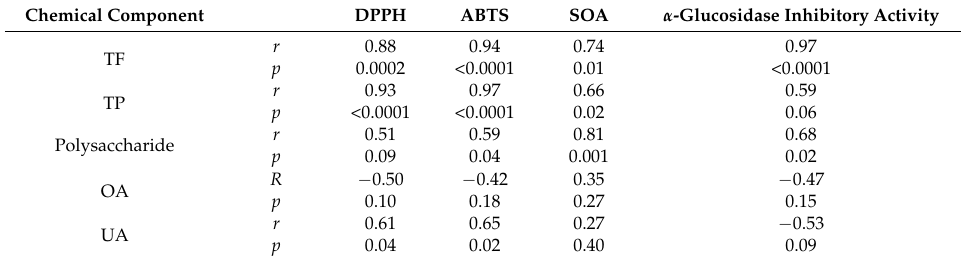
Table 5. Correlations of TF, TP, polysaccharide, OA, UA contents with antioxidant activity and α -glucosidase inhibitory activity of C.